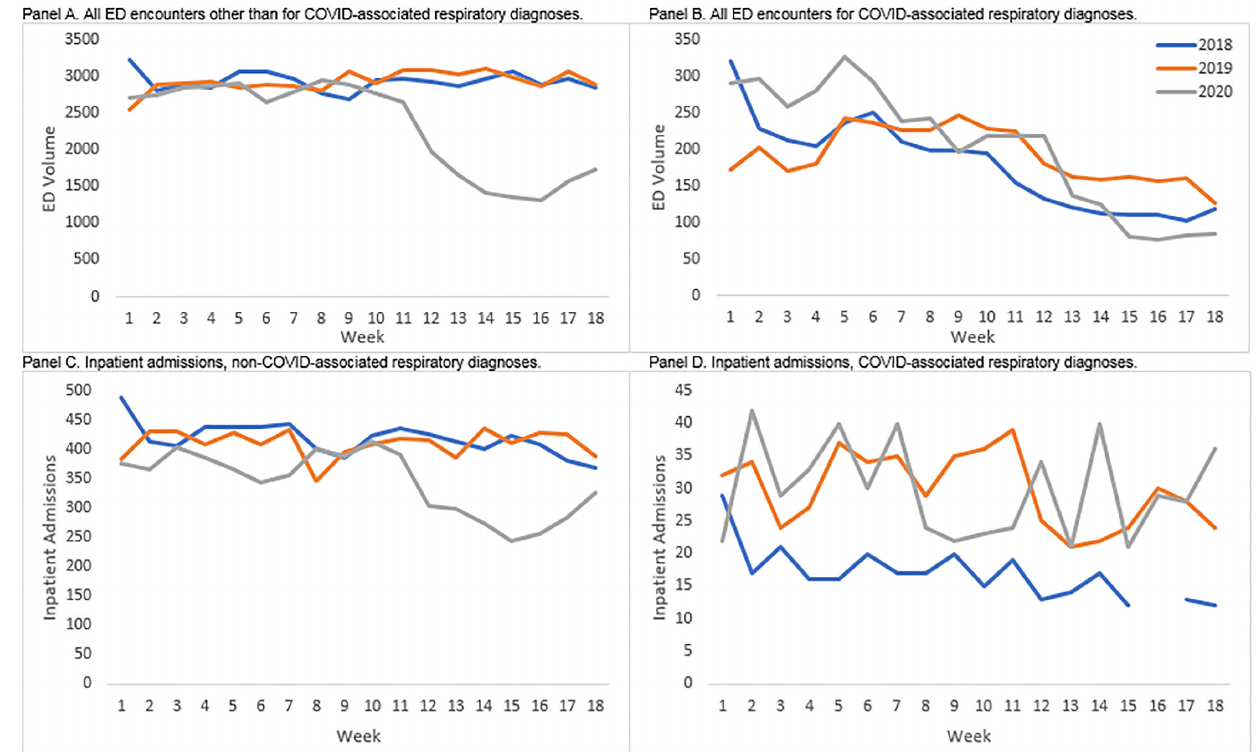
Figure 1. Total emergency department volume and inpatient admissions by week, year, and diagnosis. Notes: Values representing fewer than 10 encounters are